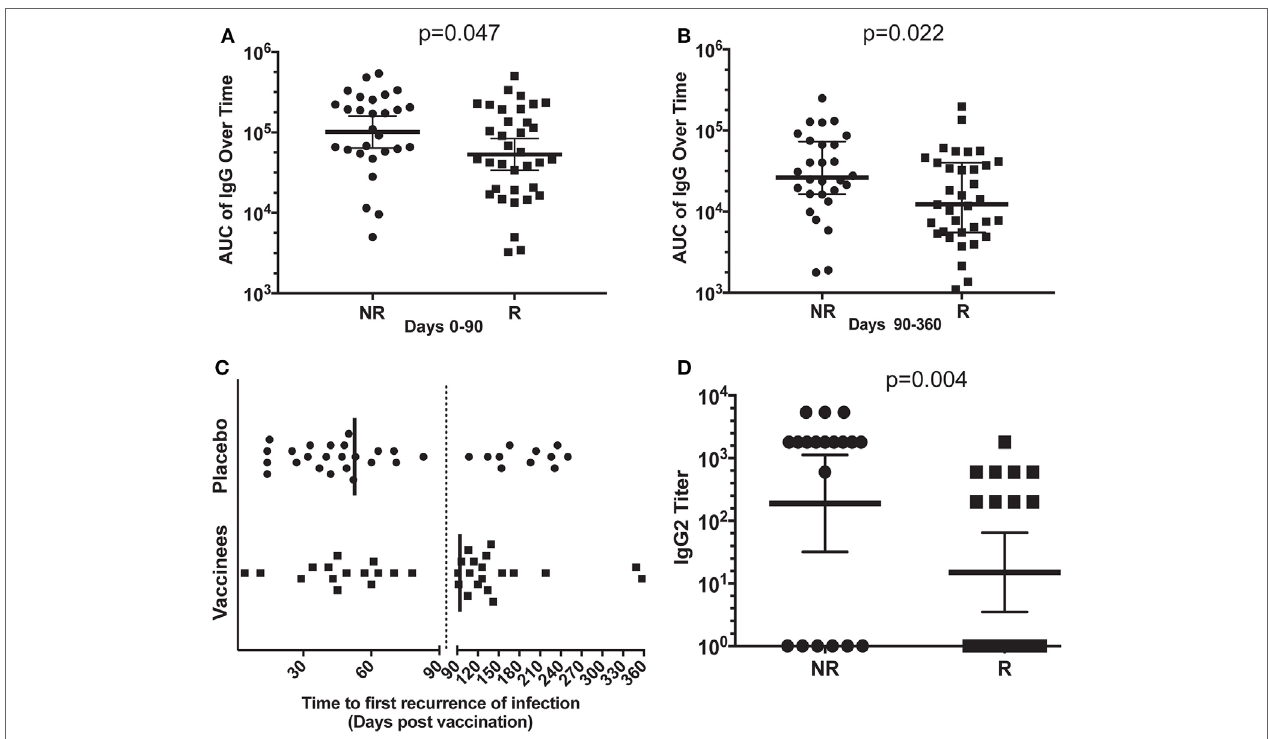
FigUre 1 | Analysis of the antibody response in vaccinated patients. Mean area under the curve (AUC) of the total IgG titers over time (0–90 and 90–360 days) for each patient, in the non-recurrent (NR) and recurrent (R) NDV-3A-vaccinated subjects was plotted. In the first 3-month post-vaccination, AUC of NR patients was significantly higher ( p = 0.046) than that of R patients (a) . In months 3–12, this difference in AUC was also significant ( p = 0.022) (B) . The decrease in AUC of the IgG titers in R patient sera in the later months corresponded with the increase in recurrent episodes of vulvovaginal candidiasis during this period (c) . Finally, significantly more number of NR patients displayed IgG2 antibodies in their sera, also mean (geometric) IgG2 antibody titer was higher in NR patients, compared with R patients ( p = 0.003) (D) . Each dot in (a,B,D) represents antibody titers in each analyzed serum samples from the indicated individual patients. Each dot in (c) represents a first relapse in infection as a function of time post-vaccination. Data in (a,B,D) are presented as geometric mean with 95% confidence